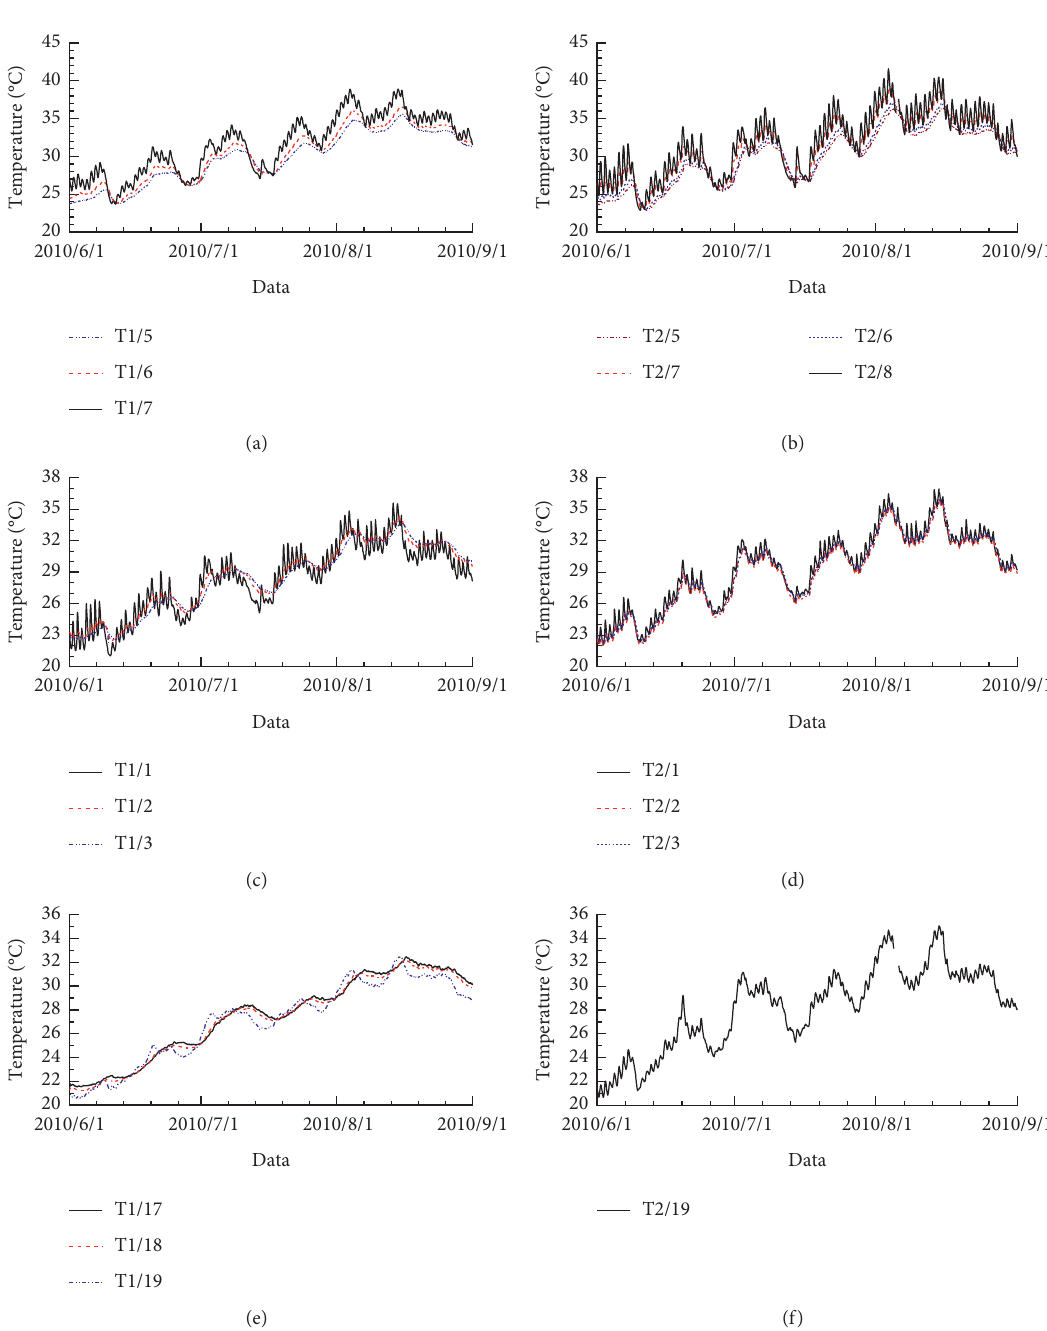
Figure 4: Temperature variations of the girder at sections T1 and T2 for the period from June 1 to August 31, 2010: (a) T1/5 ∼ T1/7; (b) T2/ 5 ∼ T2/8; (c) T1/1 ∼ T1/3; (d) T2/1 ∼ T2/3; (e) T1/17 ∼ T1/19; (f)